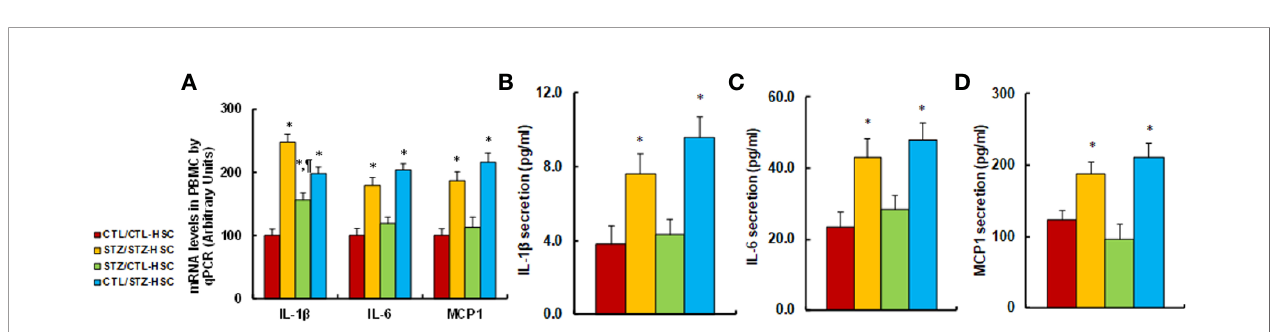
FIGURE 4 | Transplantation of bone marrow HSC reverses maternal diabetes-induced in fl ammatory cytokine release from PBMC in autistic offspring. The 6-week- old male offspring from either the control (CTL) or maternal diabetes (STZ) group received transplants of bone marrow HSC from either the control (CTL-HSC) or maternal diabetes (STZ-HSC) group, and the PBMC were isolated for further analysis. (A) mRNA levels by qPCR, n = 4. (B) IL-1 b secretion, n = 5. (C) IL-6 secretion, n = 5. (D) MCP1 secretion, n = 5. * P < 0.05, vs. CTL/CTL-HSC group; ¶ P < 0.05, vs. STZ/CTL-HSC group. Data were expressed as mean ±